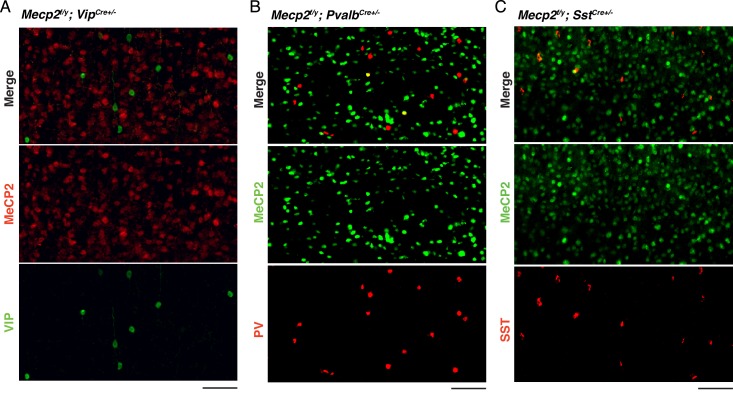
MeCP2 expression in conditional deletion mice.(A) Staining for MeCP2 (red) and VIP (green) in a Mecp2f/y VipCre+/– mouse. (B) Staining for MeCP2 (green) and PV (red) in an Mecp2f/y PvalbCre+/– mouse. (C) Staining for MeCP2 (green) and SST (red) in an Mecp2f/y SstCre+/– mouse. Scale bars denote 100 μm.